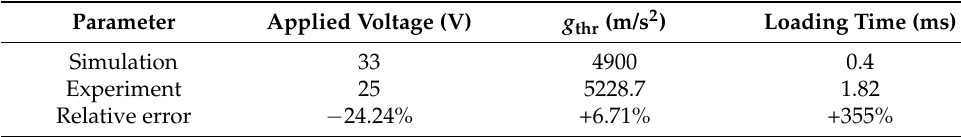
Figure 15. Output signal of oscilloscope. Table 5. Comparison between simulation and experiment.